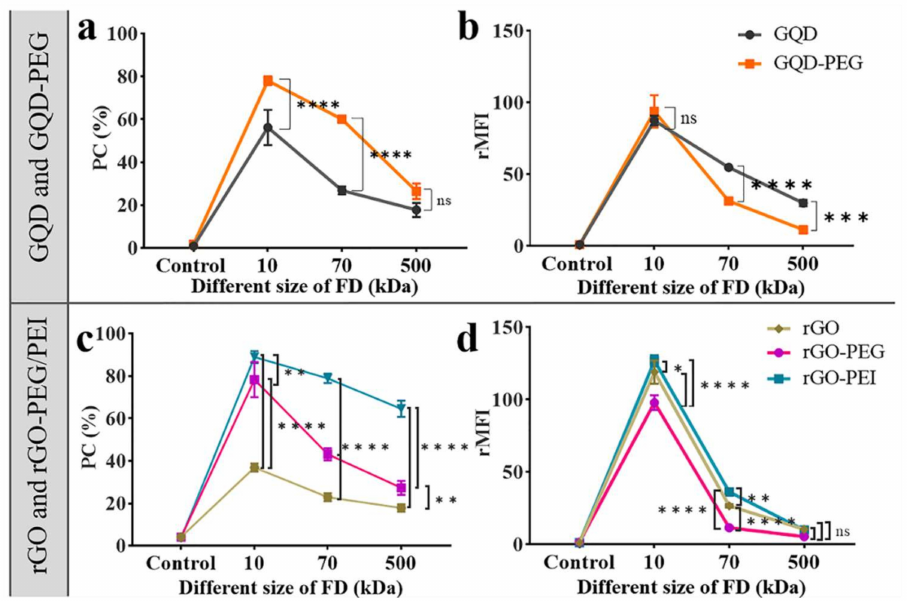
Figure 5. Flow cytometry results of HeLa cells photoporated with FD10, FD70, and FD500. ( a ) and ( b ) HeLa cells are photoporated using 3.56 × 10 9 nps / mL GQD and 5.1 × 10 9 nps / mL GQD-PEG, respectively. ( c ) and ( d ) HeLa cells were photoporated using 1.31 × 10 9 nps / mL rGO, 0.82 × 10 9 nps / mL rGO-PEG, and 12.8 × 10 8 nps / mL rGO-PEI, respectively. ( a ) and ( c ) Positive cells were quantified by flow cytometry. ( b ) and ( d ) rMFI of positive cells. **** p < 0.0001, *** p < 0.001, ** p < 0.01, and ns = not